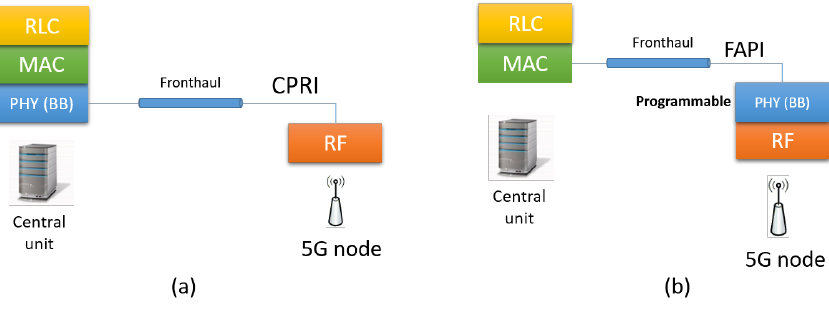
Figure 2. Protocol stack splitting alternatives: CPRI-based ( a ); FAPI-based ( b